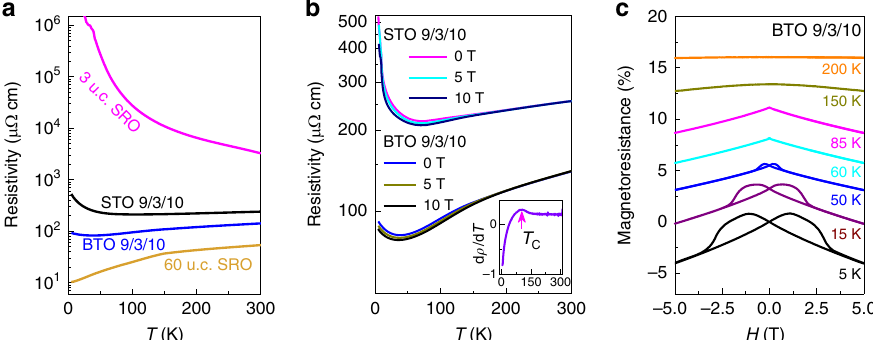
Fig. 2 Transport properties in BTO 9/3/10 and STO 9/3/10. a Temperature dependence of longitudinal resistivity ρ for the BTO 9/3/10, STO 9/3/10, 3 u.c. SRO, and 60 u.c. SRO fi lms. The BTO 9/3/10 has low resistivity compared to STO 9/3/10 and bare 3 u.c. SRO fi lm. b Temperature dependence of longitudinal resistivity of BTO 9/3/10 and STO 9/3/10 under various magnetic fi eld. Metallic behavior is observed at all fi elds. Inset: temperature dependence of the derivative d ρ /d T of BTO 9/3/10. A clear kink around 125 K is the typical feature of magnetic transition in SRO. c Magnetoresistance of BTO 9/3/10 at different temperatures. The butter fl y loop indicates ferromagnetism in BTO